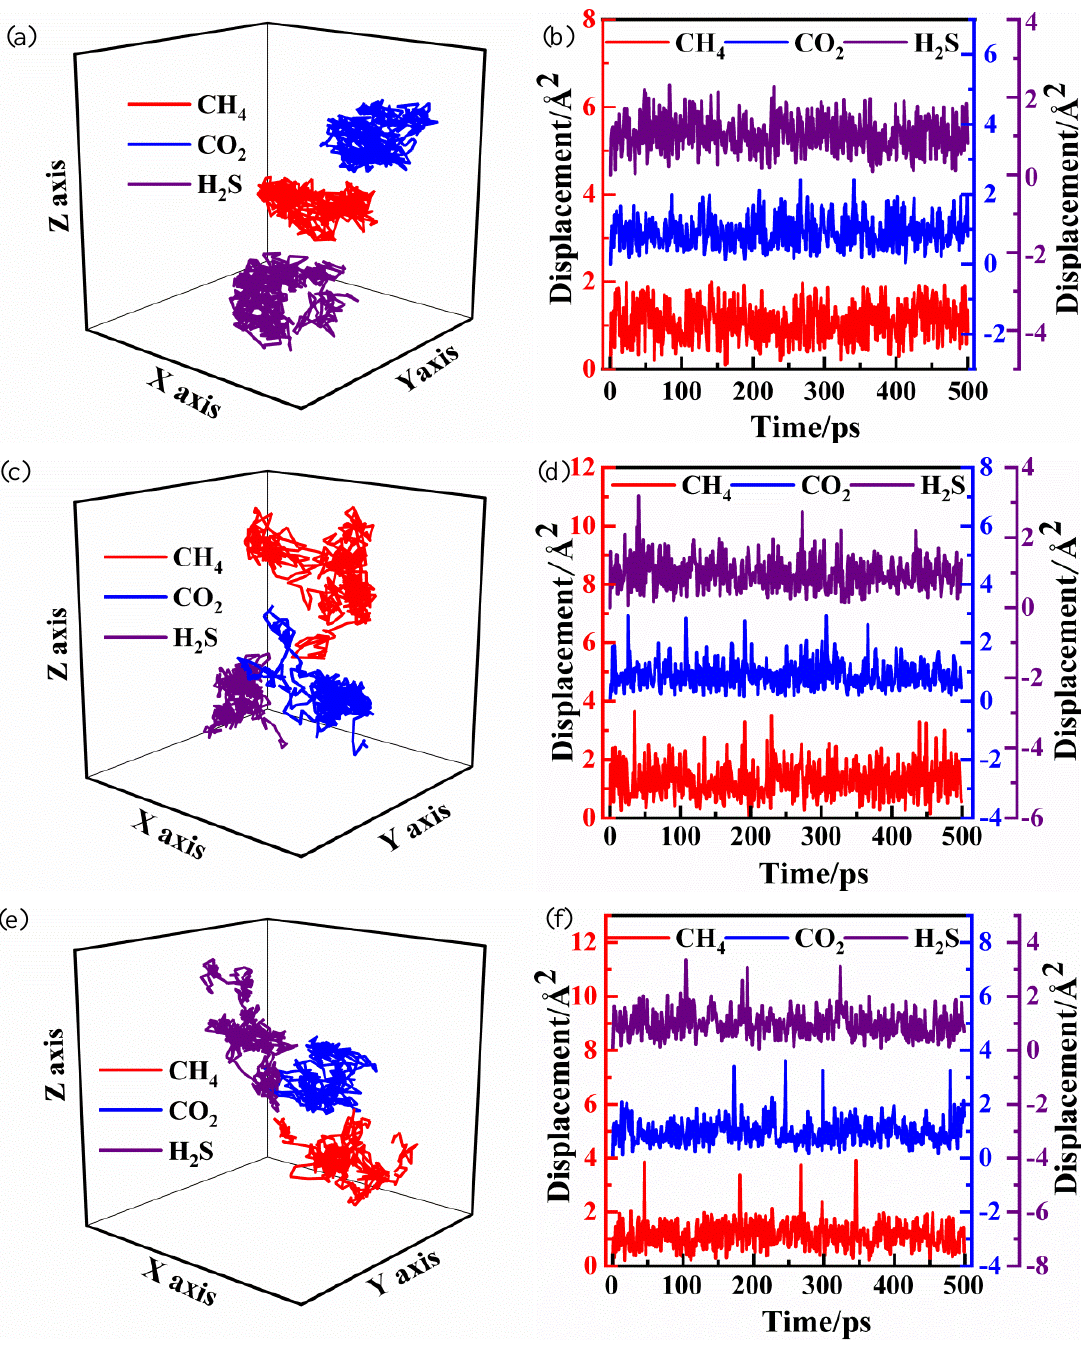
Figure 9. The diffusion trajectory and displacement of single gas molecules in PVDF under different conditions in CH 4 /CO 2 /H 2 S mixed gas medium: ( a , b ) 2.5 MPa, 30°C; ( c , d ) 2.5 MPa, 40°C; ( e , f ) 6.4 MPa, 30 °C.